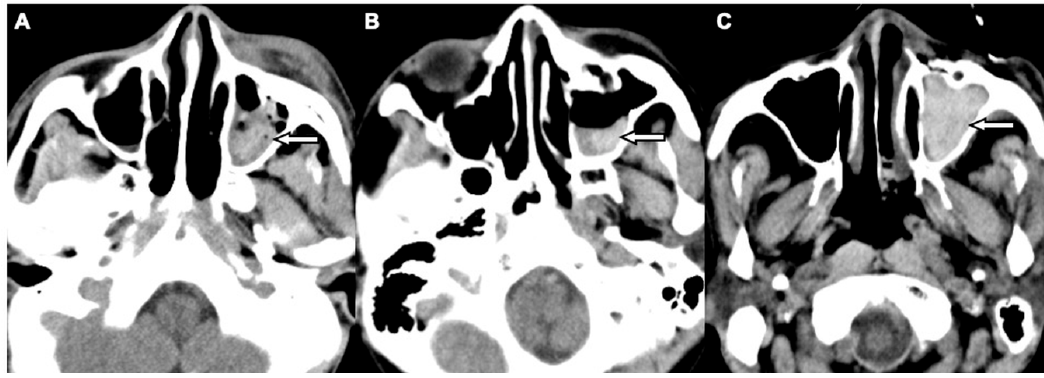
Figure 3. CT images showing three patterns of MHS related to OFFs associated with head trauma. ( A ) Type 1: high-attenuation opacity mixed with mottled gas in the left maxillary sinus (arrow) in a 52-year-old male with motorcycle crash-related head trauma. ( B ) Type 2: air–fluid level in the left maxillary sinus (arrow) in a 26-year-old female with motor vehicle collision-related head trauma. ( C ) Type 3: full opacification of the left maxillary sinus (arrow) in a 79-year-old male with fall accident-related head trauma.